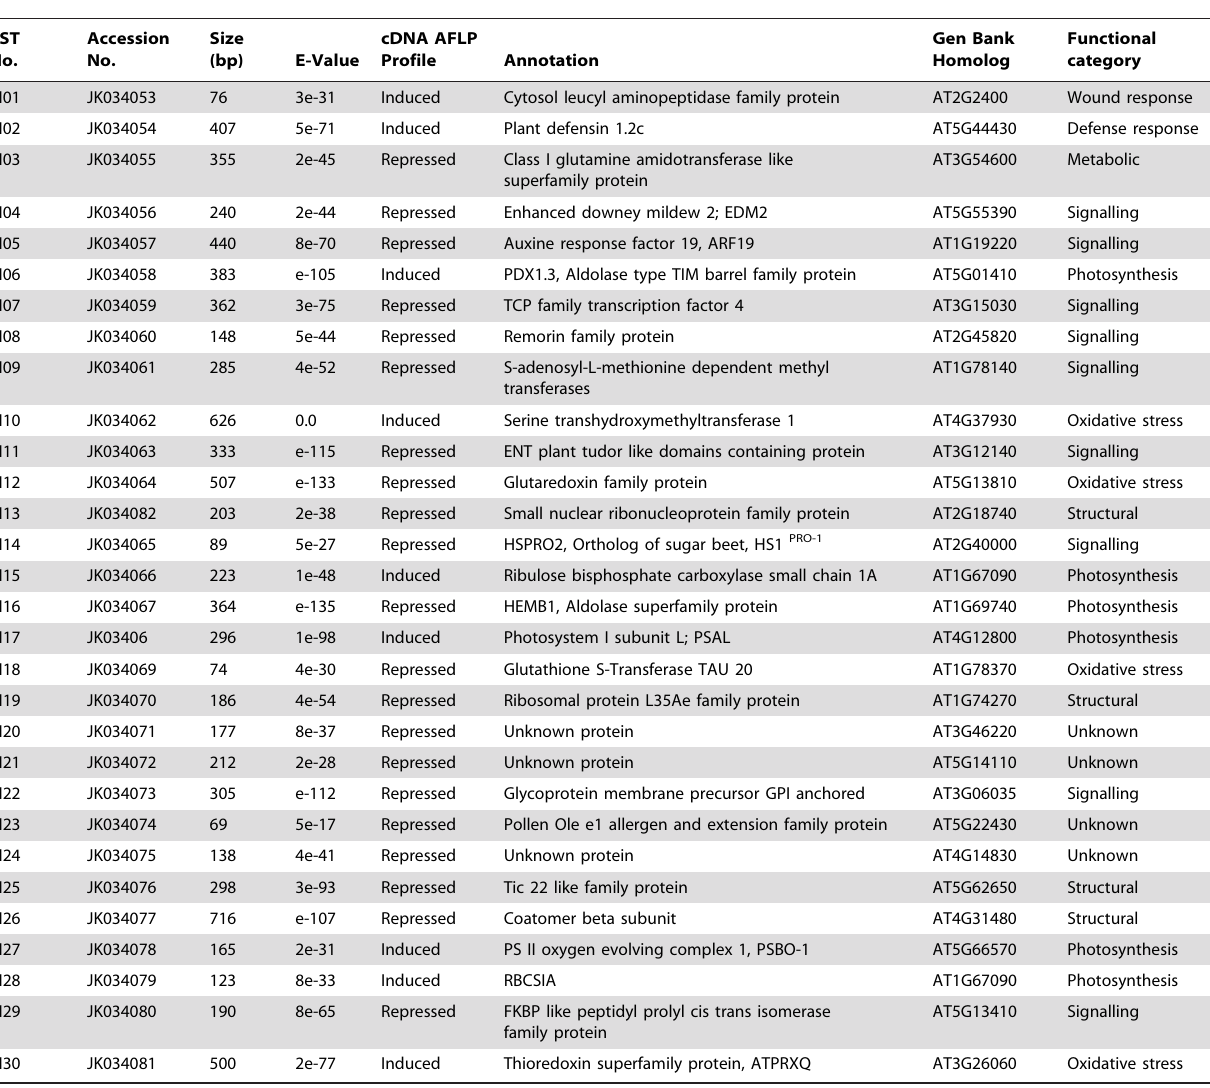
Table 1. The candidate resistance response TDFs identified in the transcriptomic analysis of R. indica- L. erysimi interaction.